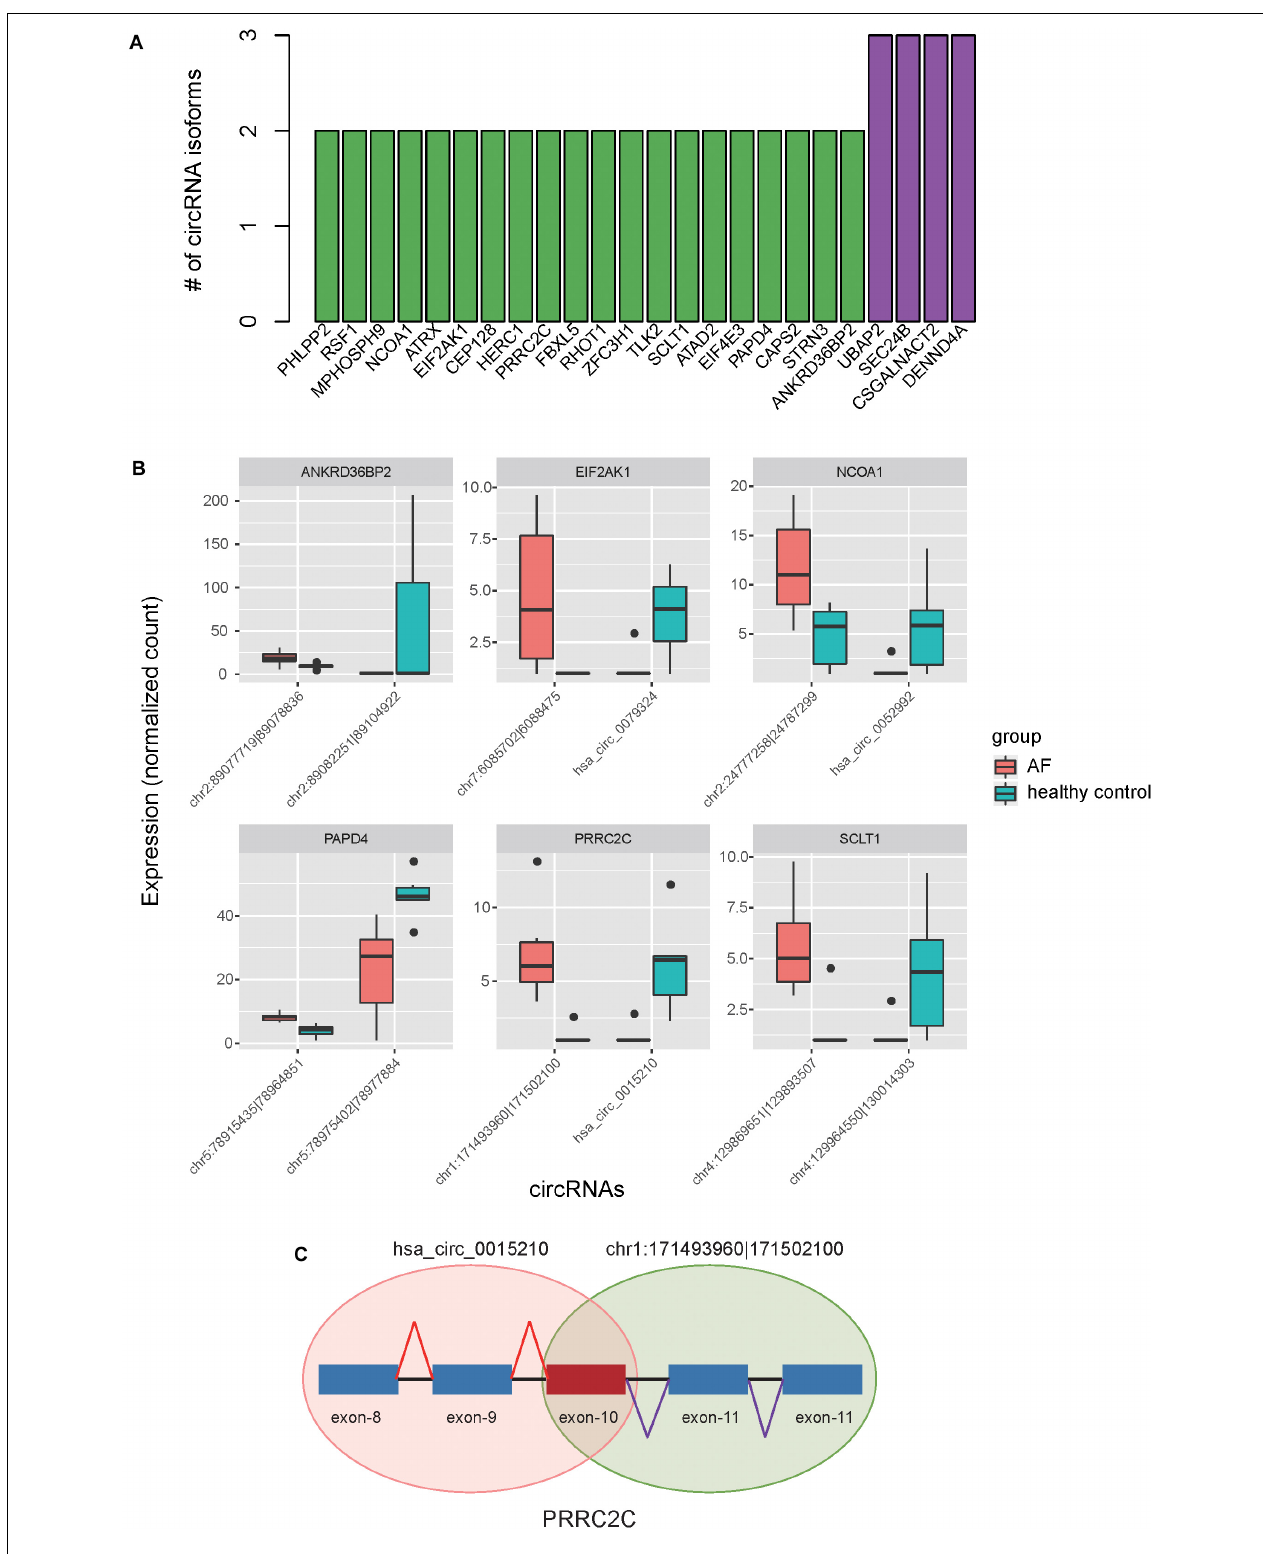
FIGURE 4 | Alternative circularization of the dysregulated circRNAs. (A) The number of circRNA isoforms for the parental genes with alternative circularization. (B) Expression levels of switched circular RNA isoforms for six parental genes between AF and healthy controls. (C) The schematic diagram for the two circRNA isoforms in PRRC2C with differential usage of the 10-th